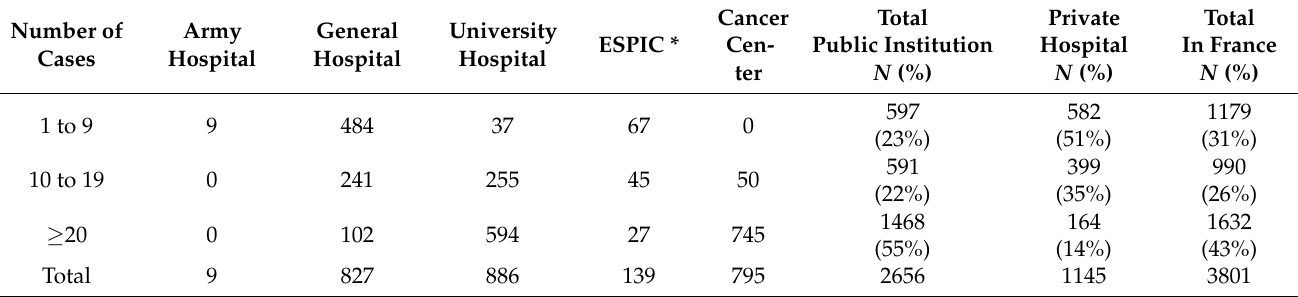
Table 4. Distribution of patients who underwent a debulking surgical procedure in 2018 by type of